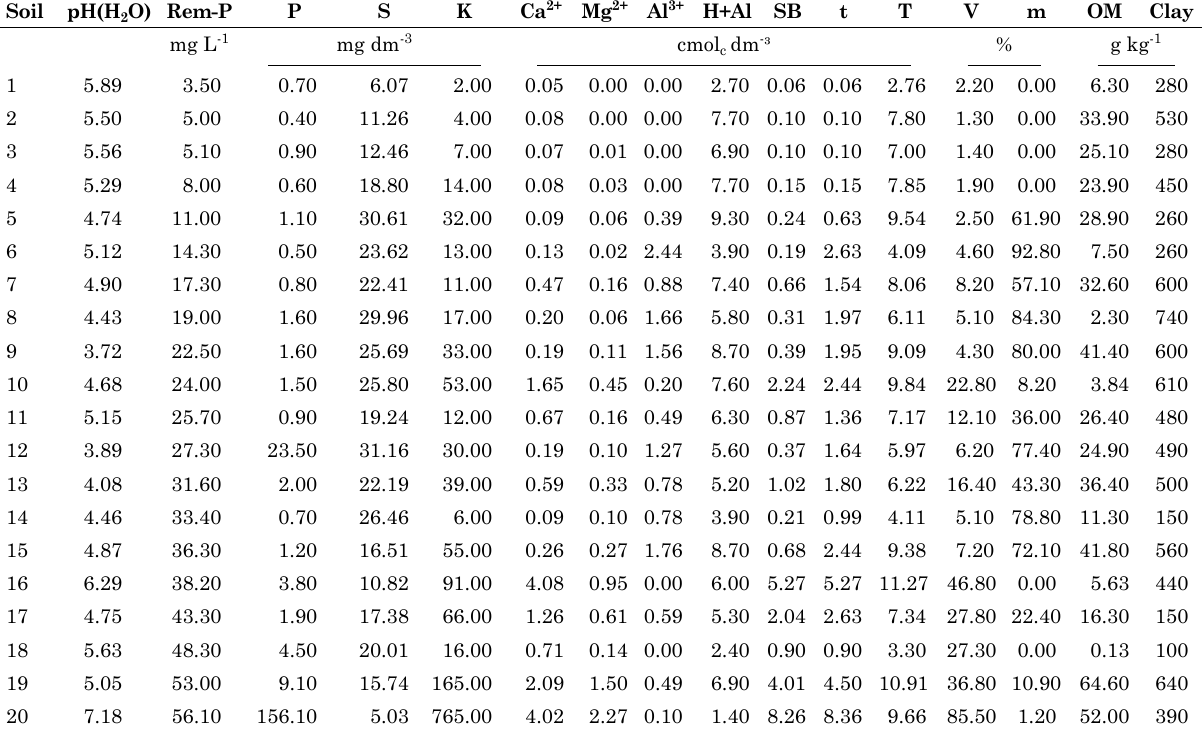
table 1. results of the routine chemical analyses and the clay content of the soils soil ph(h 2 o)